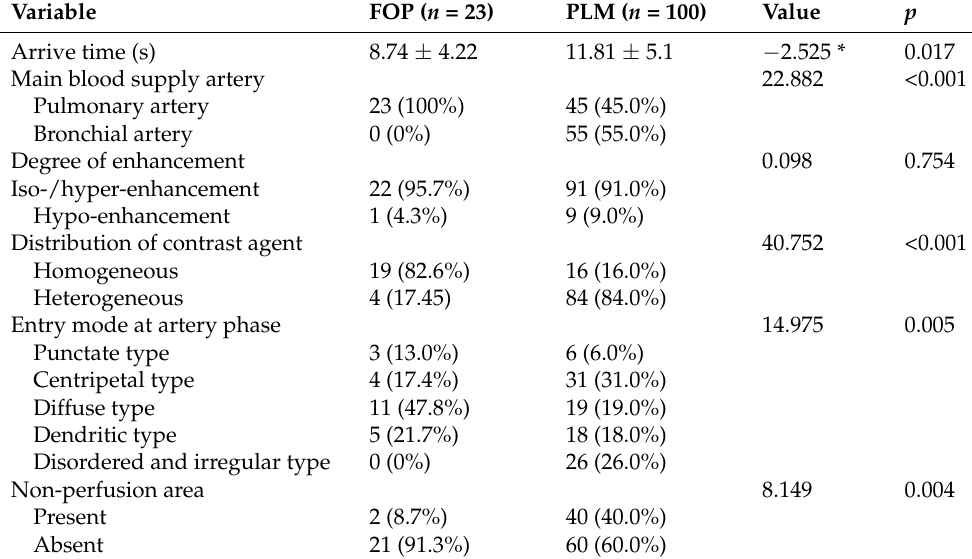
Table 3. Univariate Analysis of Contrast-Enhanced Ultrasound Parameters.